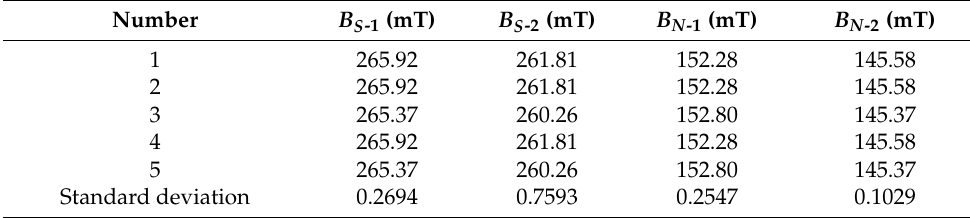
Table 2. Measurement results.